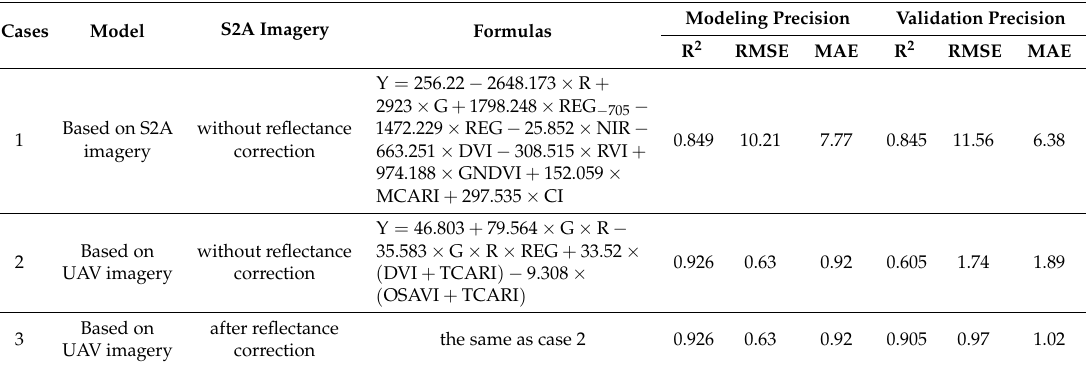
Table 9. Validation of SPAD inversion model.